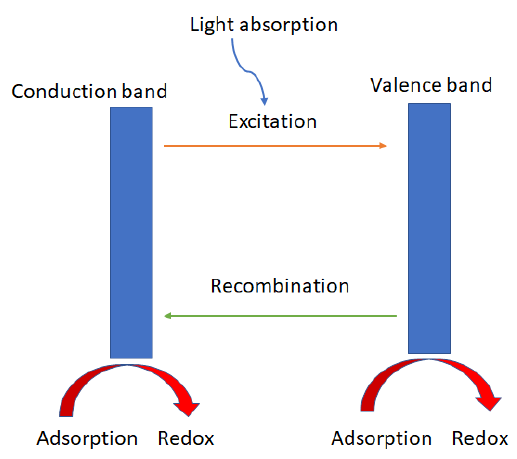
Figure 6. Schema of the typical photocatalytic processes on a heterojunction photocatalytic material.